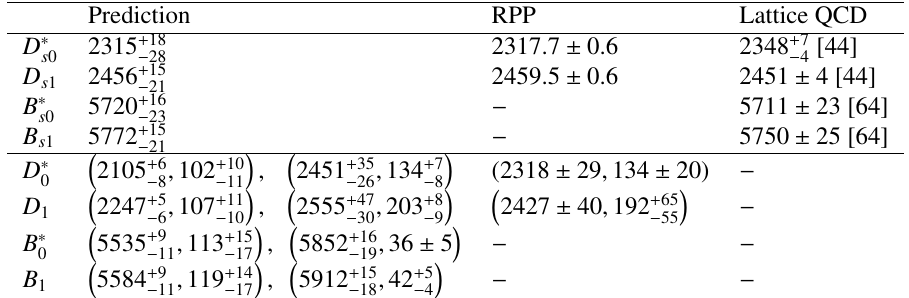
Table 2. Predicted masses of the 0 + and 1 + heavy-strange mesons, and poles given as ( M , Γ / 2) for the 0 + and 1 + heavy-nonstrange mesons. Here M and Γ are the mass and the total decay width, respectively. For comparison, the RPP values [13] and latest lattice QCD results are also shown. All values are in units of